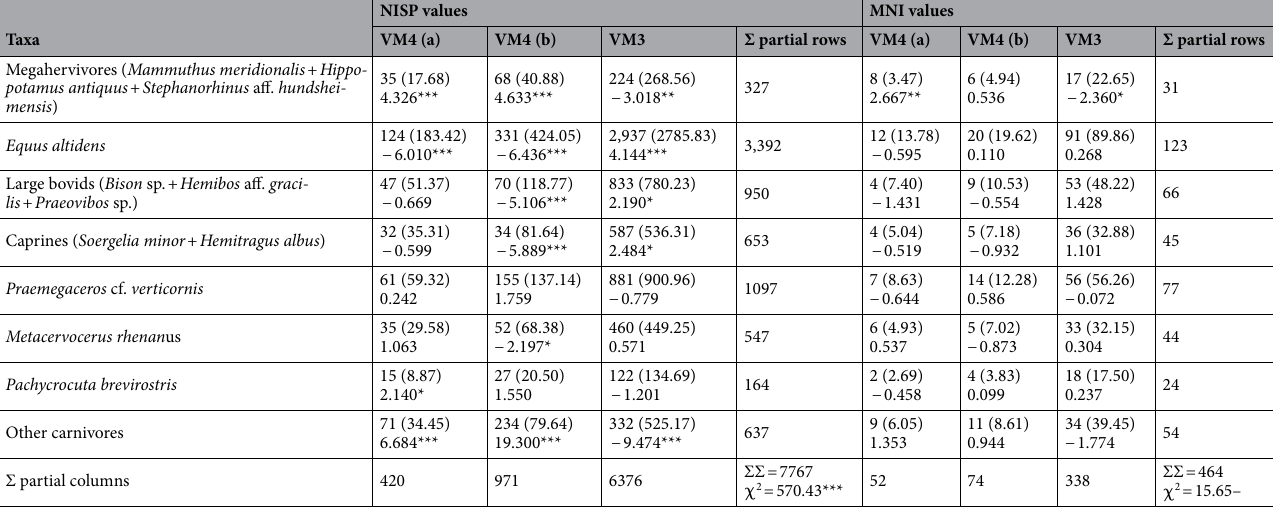
Table 2. Contingency tables for the abundance of large mammals in the assemblages of the two excavation quarries of Venta Micena compared in this study, VM4 (a: data published by Luzón et al. 1 for the fossils unearthed during the years 2005 and 2019–2020; b: unpublished data analysed by M.P. Espigares for the fossils of 2005 and 2013–2015) and VM3 (updated from Ref. 9 ). Separate tables are provided for the number of identifiable specimens (NISP, left table) and the estimates of minimum number of individuals (MNI, right table). The cells of each contingency table show the observed frequencies (OF), the frequencies expected from a random distribution (EF, between brackets), the adjusted residuals (normal deviates) and the level of statistical significance according to a two-tailed t-test ( – p > 0.05,*p < 0.05,**p < 0.01,***p < 0.001). The tables also include the cumulative χ 2 -values [Σ i Σ j (OF − EF) 2 /EF] with (r − 1) (c − 1) = 14 degrees of